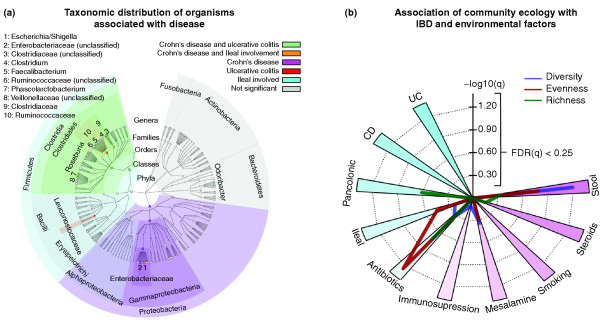
Significant associations of microbial clade abundance and community ecology with IBD and treatment. (a) Taxonomic distribution of clades significant to disease and ileal involvement. Abundant clades not significantly associated with IBD are annotated in gray for context (top 90th percentile of at least 10% of samples and including 5+ genera). Node (non-associated clade) sizes are proportional to the log of the clade's average abundance. (b) Significance of association of sample ecology with disease (CD/UC, ileal/pancolonic), treatment (antibiotics, immunosuppression, mesalamine, steroids), and environment (smoking, stool/biopsy sample origin). Diversity (Simpson's index), evenness (Pielou's index), and richness (Chao1) were calculated for each community (see Materials and methods). False discovery rate q-values are -log10 transformed for visualization, such that values > 0.60 correspond to q < 0.25. Antibiotic treatment is strongly associated with reduced diversity, and stool samples with increased diversity relative to biopsies.